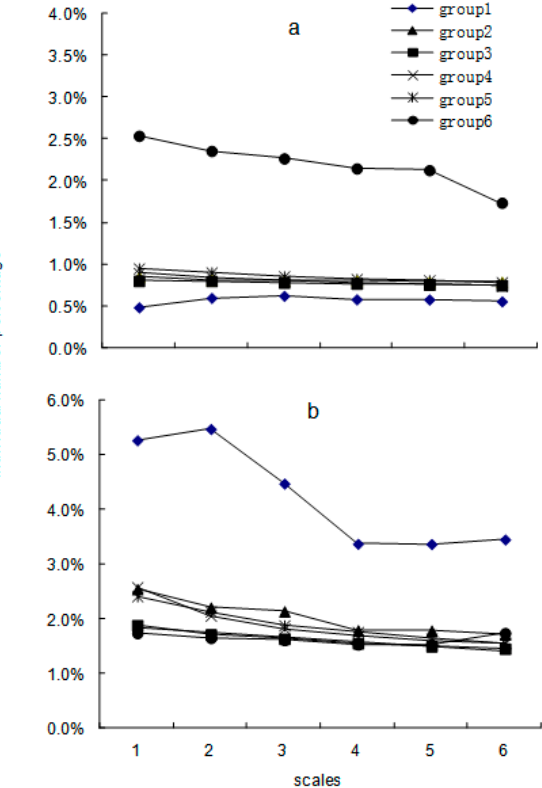
Figure 3. Six species groups quantitative distribution around Castanopsis chinensis at six scales in succession forest ( a ) and mature forest ( b ). Horizontal axis is scales number representing outer diameter of annulus around C. chinensis : 20 m, 28.28 m, 34.64 m, 40 m, 44.72 m, and 48.99 m. The vertical axis represents percent of neighbors within that group.